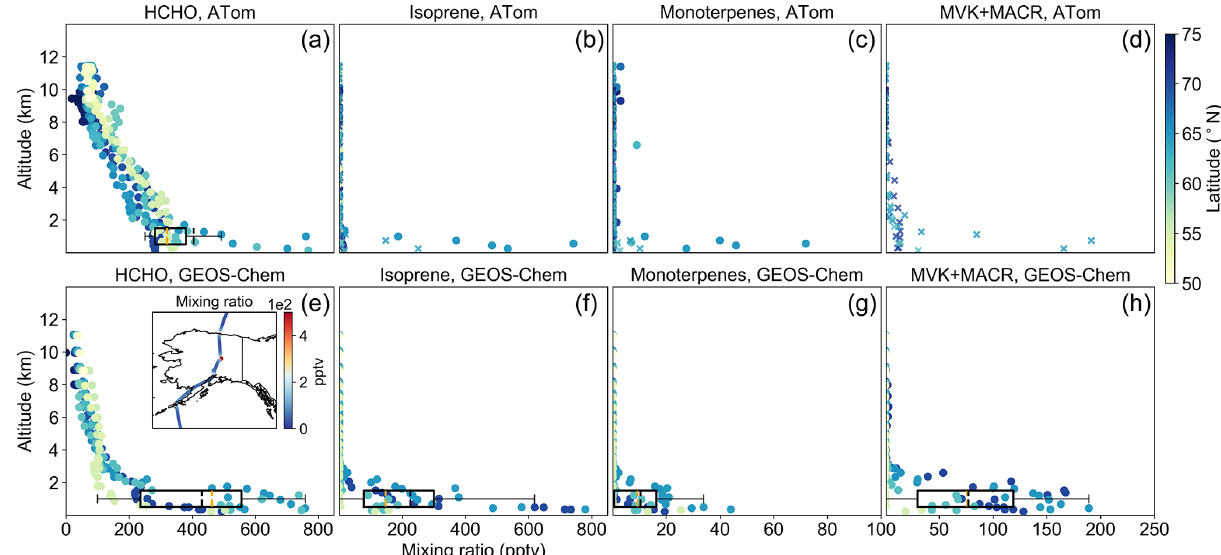
Figure 1. Vertical profiles of HCHO, isoprene, monoterpenes and MVK + MACR mixing ratios from ATom-1 and GEOS-Chem, along the ATom-1 flight track from 1 August 2016, 20:11UTC, to 3 August 2016, 21:20UTC. GEOS-Chem data are resampled along the ATom-1 flight track. Panels (a) to (d) are from ATom-1, panels (e) to (h) are from GEOS-Chem simulation. The subpanel in (e) shows a GEOS-Chem HCHO mixing ratio along the ATom-1 flight track crossing Alaska. For panels (b) to (d) , circles represent values measured by WAS, and crosses represent measurements from TOGA. Box plots represent data distribution in < 2km layers. Orange dashes show the median values, and black dashes show the mean